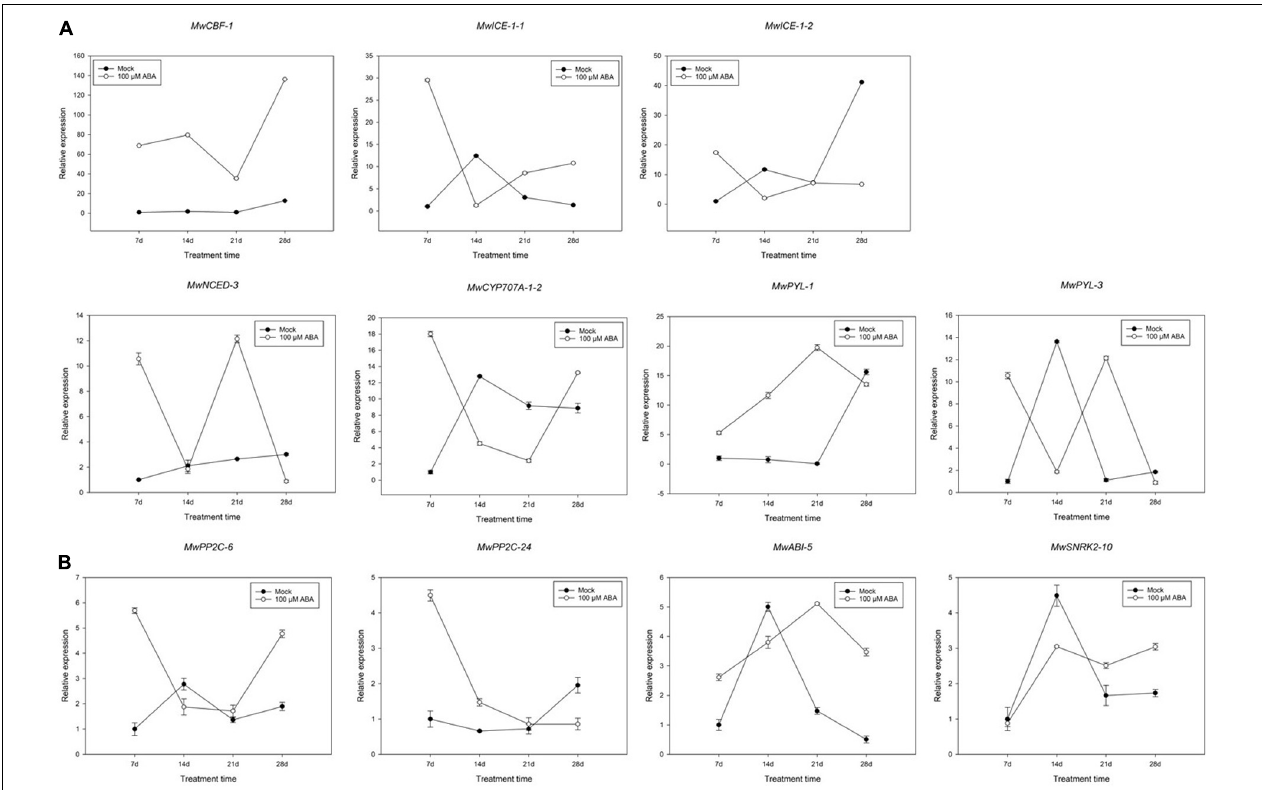
FIGURE 8 | Relative gene expression levels of specific differentially expressed genes (DEGs) involved in abscisic acid (ABA) (A) and cold resistance (B) under ABA treatment during 2020–2021 in Magnolia wufengensis . Each experiment was performed with three biological replicates. Each bar represents the mean ± SEM of three biological